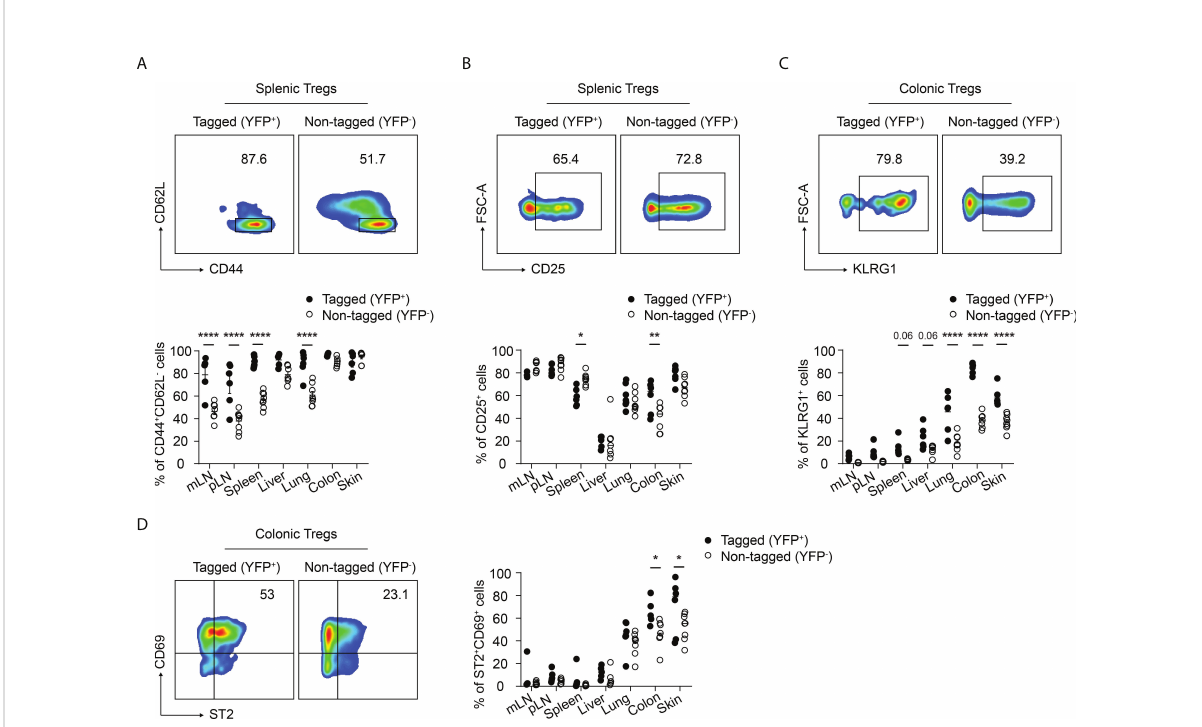
FIGURE 2 Immunophenotype of neonatally-tagged Tregs in adult mice. Foxp3 eGFPCreERT2 xROSA26 STOP-eYFP mice received repetitive intragastric tamoxifen injections at days 2, 5 and 8 after birth, and were sacri fi ced for immunophenotyping at 12 weeks (day 85) after birth. (A – D) Representative plots show CD62L and CD44 expression (A) , CD25 expression (B) , KLRG1 expression (C) , and CD69 and ST2 expression (D) among non-tagged (YFP - ) and tagged (YFP + ) Foxp3 + Tregs from indicated organs. Scatter dot plots summarize the frequencies among non-tagged (open circle) and tagged Tregs (black circle) across indicated organs. Data in scatter dot plots are depicted as mean ± SD, each dot represents a single mouse, and data were pooled from 3 to 6 independent experiments (n = 6-8). * p < 0.05, ** p < 0.01, **** p <